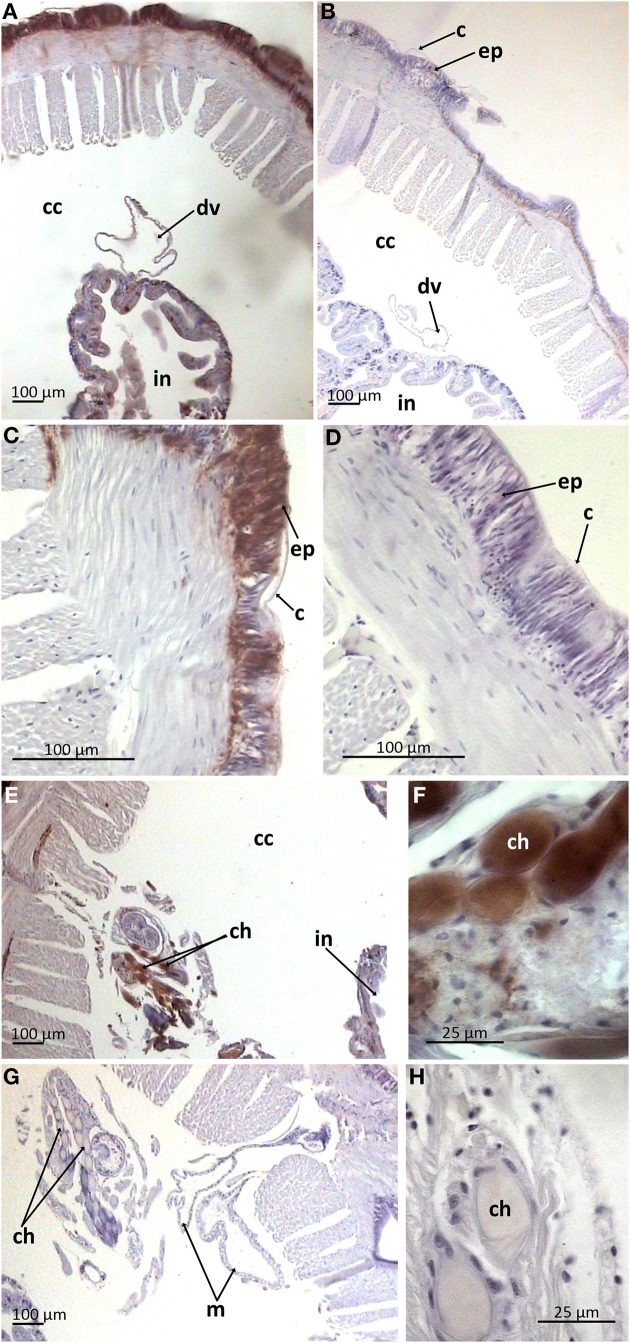
Arenicin-positive immunoreactivity of lugworm body wall. A,B, General view of dorsal body part; C,D, body wall; E,F, chaetae complex; B,D,G,H, negative controls; c, cuticle; cc, coelomic cavity; ch, chaetae; ep, body wall epithelium; in, intestine; m, metanephridia.